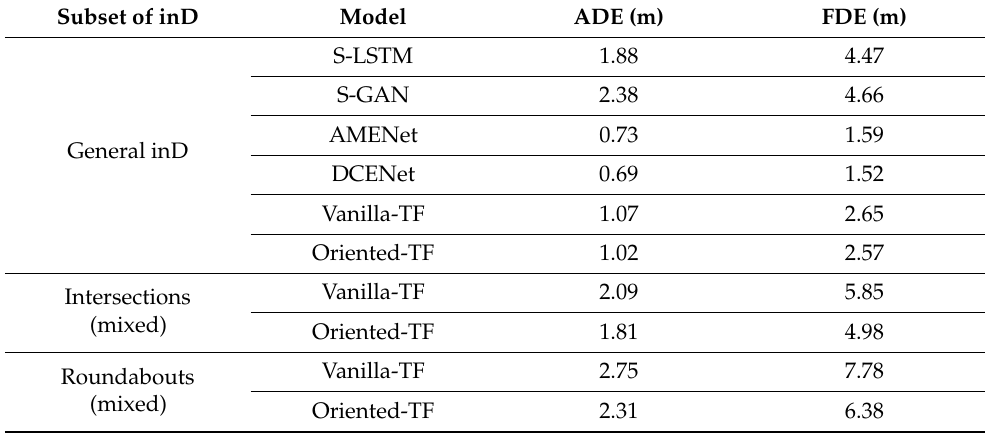
Table 6. Performance of vehicle trajectory prediction models on the inD dataset reported in